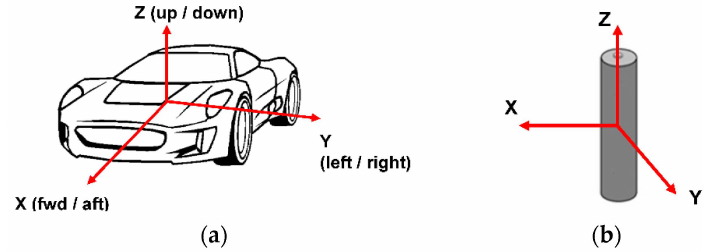
Figure 8. ( a ) Axis convention of vehicle vibration durability profiles, ( b ) Axis convention of